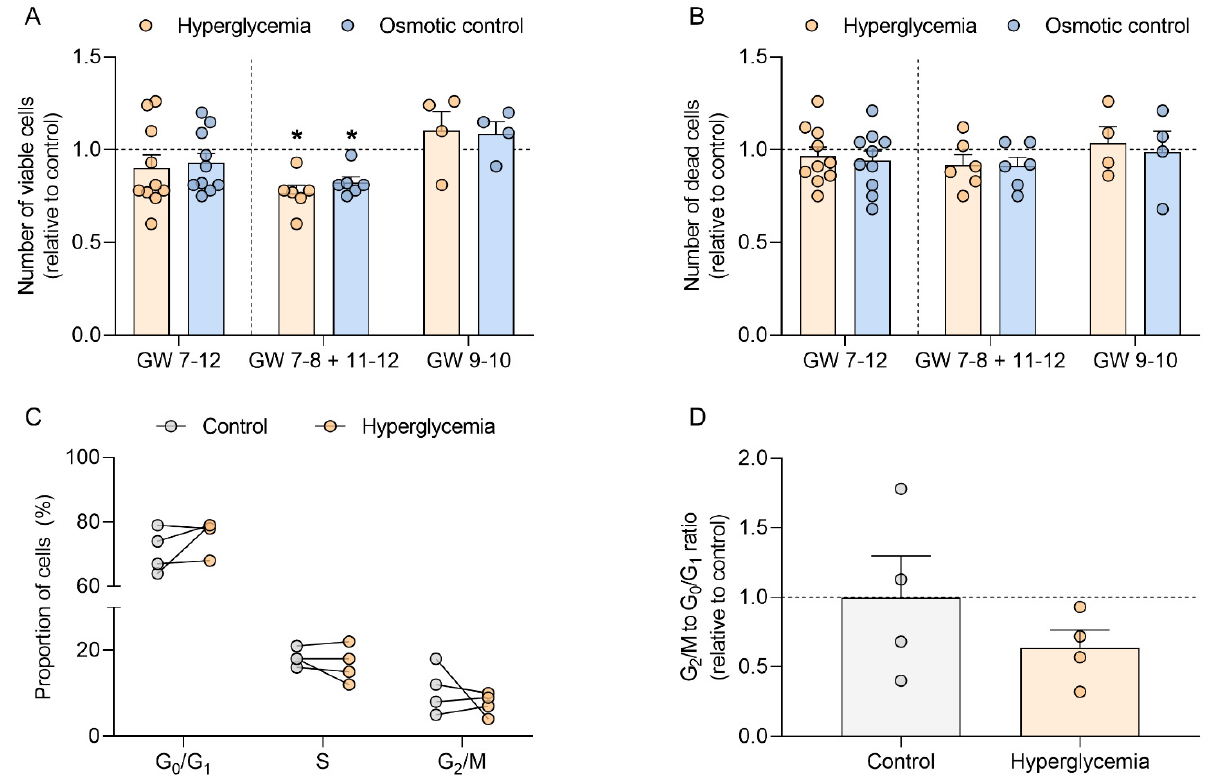
Figure 2. Ki67 localizes to villous cytotrophoblasts (VT) in early pregnancy. Ki67 immunostaining was performed in con- trol first trimester placental tissue ( n = 1, gestational week 7, ( A )). Ki67 was predominantly located in the nuclei of VT (open arrowheads). A negative IgG isotype control is shown in ( B ). Scale bar: 100 µm. VT: villous cytotrophoblasts; ST: syncytiotrophoblast; S: stroma.